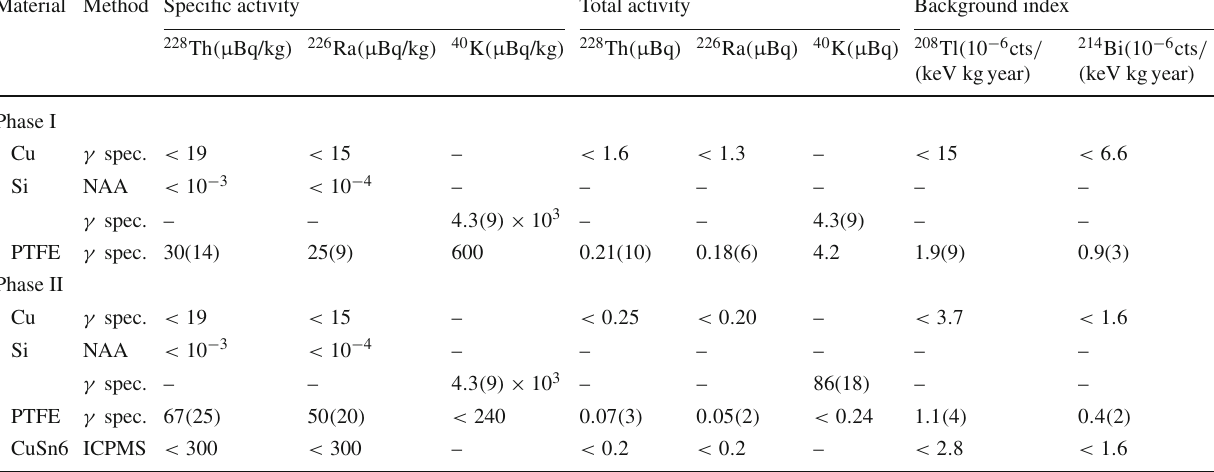
Table 8 Comparison of the radiopurity of the Phase I and II detec- tor holders (for masses of construction materials see Table 2). Spe- cific activities from neutron activation analysis (NAA) [34] and ICPMS